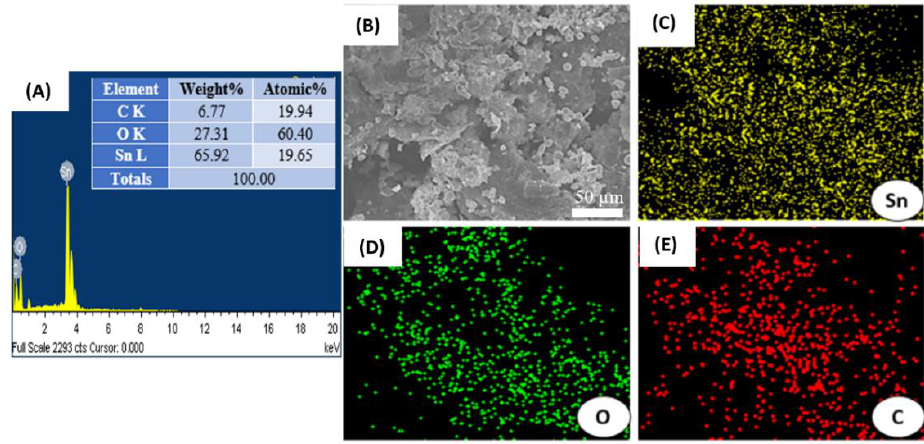
Figure 4. The elemental composition of the SnO 2 -rGO NCs by EDX ( A ). SEM elemental mapping of the SnO 2 -rGO NCs: ( B ) tin (Sn); ( C ) oxygen (O); ( D ); carbon (C) ( E ).